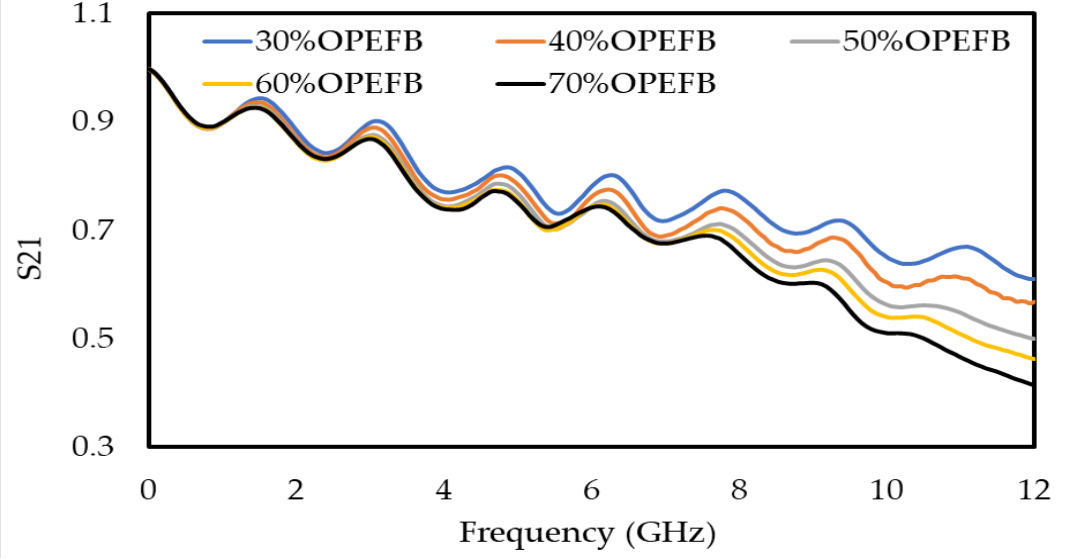
Figure 7. Variation in transmission (S 21 ) for OPEFB/PLA composites at different percentages of OPEFB filler.